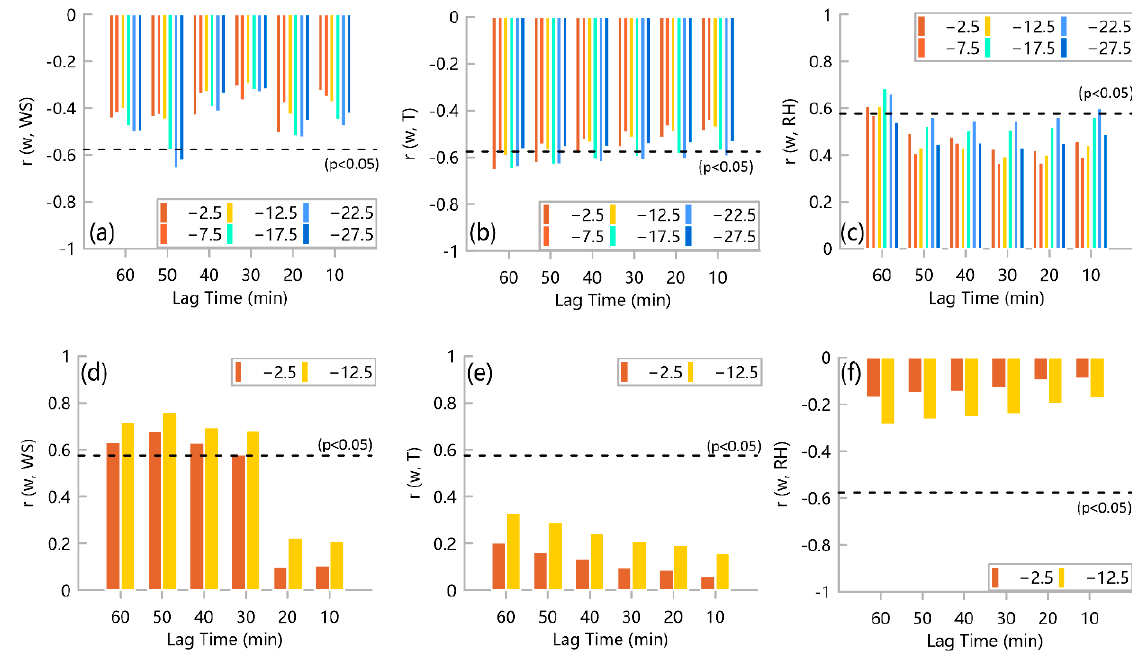
Figure 8. The relationship between water content (w) of sand layer at different depths and wind speed (WS), air temperature (T) and relative humidity (RH), where “ − 2.5” represents 0–5 cm depths, “ − 7.5” represents 5–10 cm depths, etc. ( a ), ( b ) and ( c ) were for the lake basin; ( d ), ( e ) and ( f ) were for the non-lake basin.